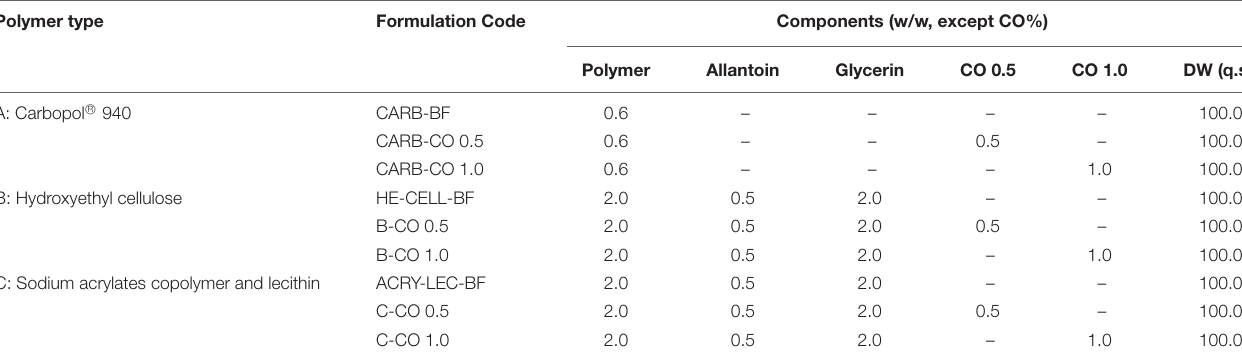
TABLE 2 | Chemical composition of formulations enriched with copaiba